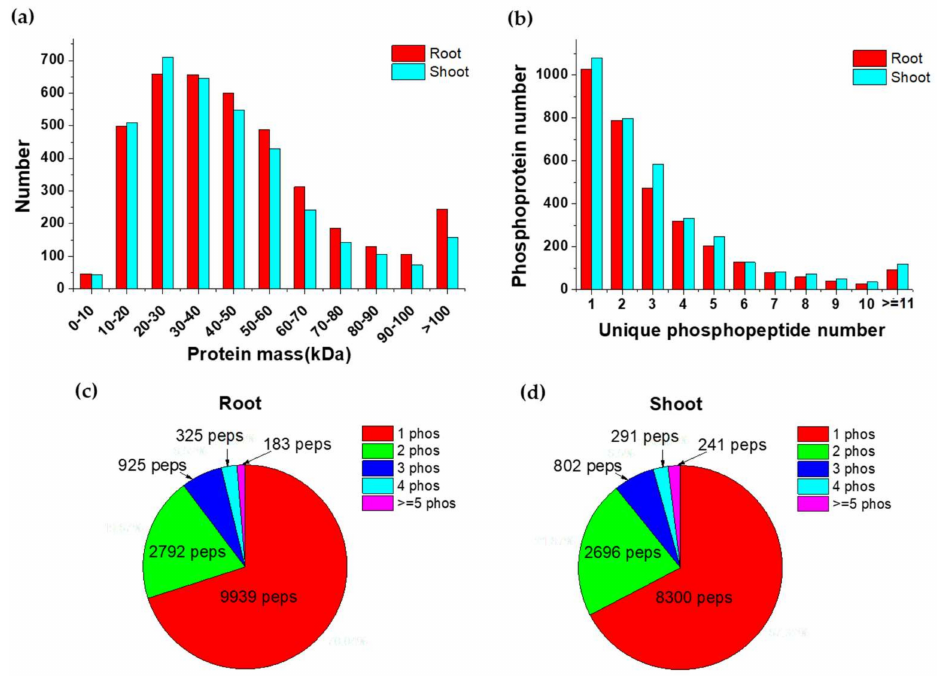
Figure 3. Overview of phosphoprotein identification. Distribution of protein mass ( a ) and numbers of unique peptides ( b ) of identified proteins. The phosphorylation status of the identified phosphopeptides in roots ( c ) and shoots ( d